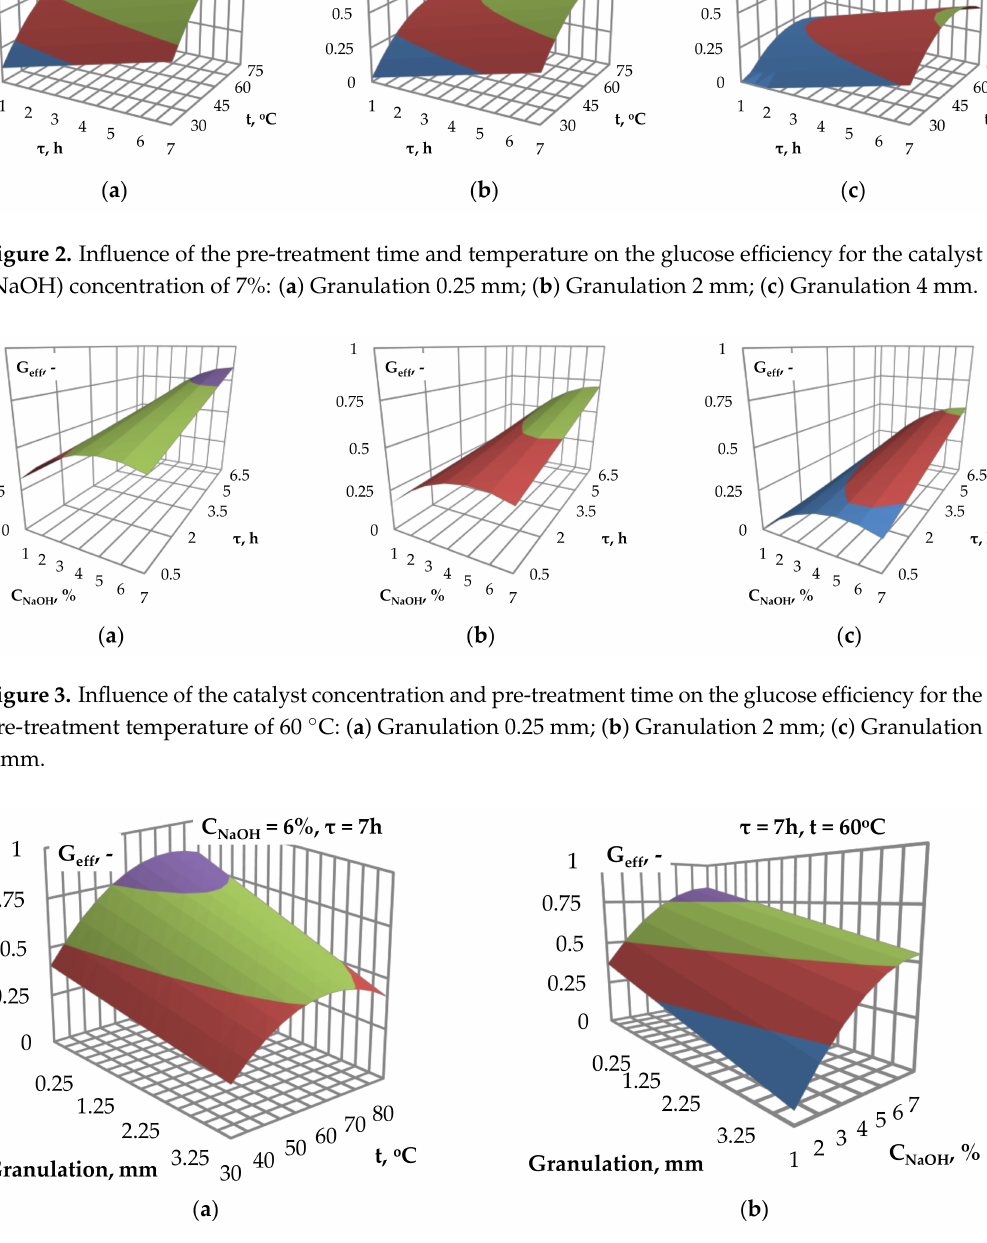
Figure 4. The surface response plots for the effect of granulation and temperature ( a ) and granulation and concentration ( b ) on the glucose